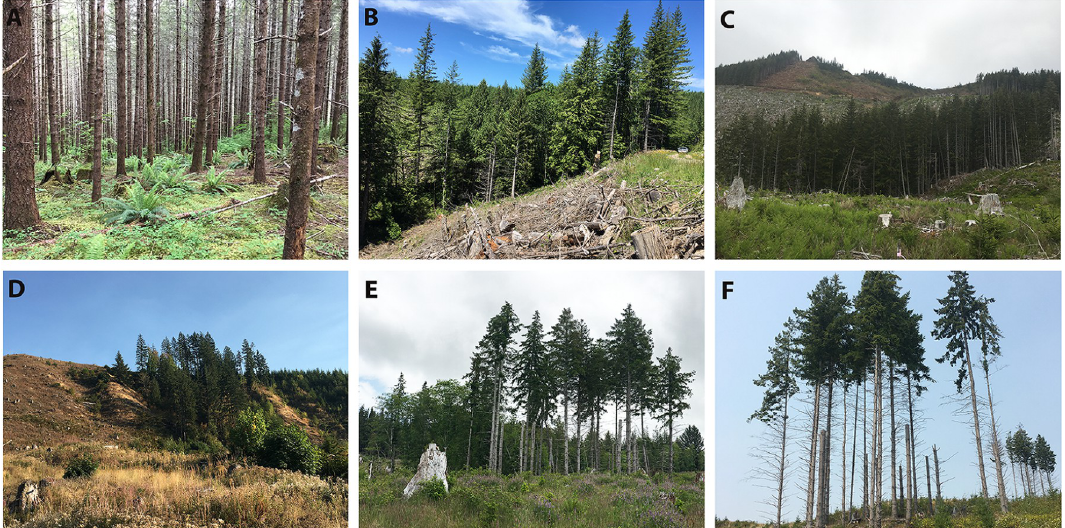
Fig 2. Examples of retention patches within clearcuts from the five experimental treatments and an unharvested rotation-aged stand (a). (b) a riparian-aggregated patch with riparian buffer zone in lower left, (c) an upland-aggregated patch in the center of a clearcut, (d) an upland patch from a split retention treatment adjacent to a regenerating stand, (e) a riparian patch from a split retention treatment with created snags and riparian buffer zone in lower left, and (F) a patch from the dispersed with snags treatment with a second patch within stand visible in background, northwest Oregon and southwest Washington, USA,